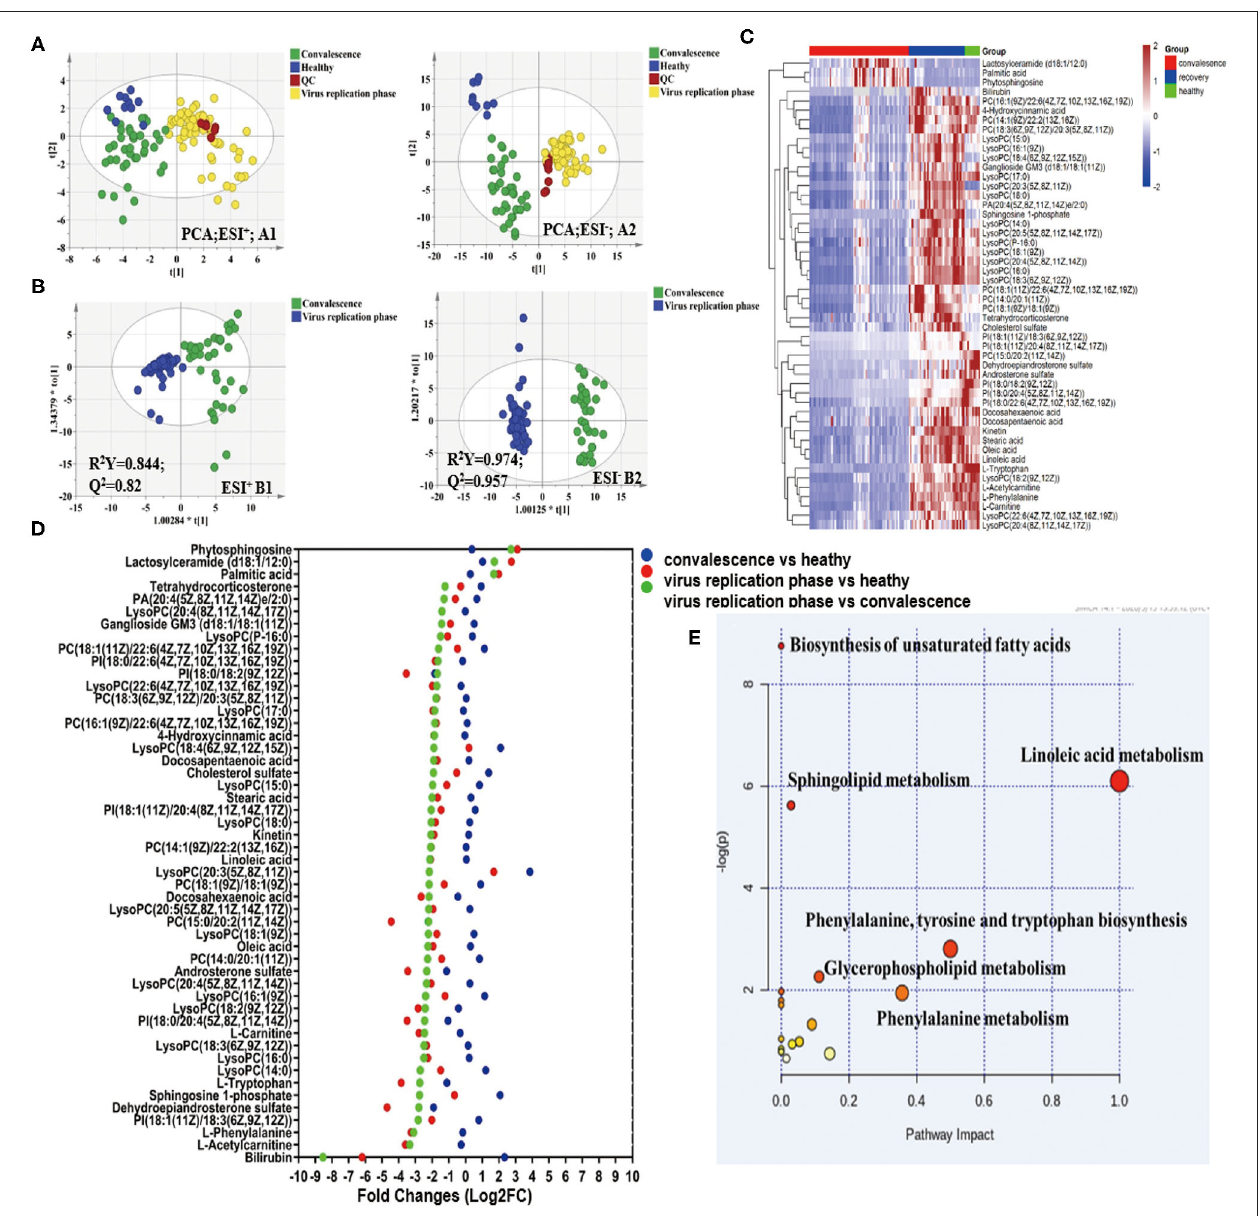
FIGURE 4 | Metabolomic profiling of COVID-19 patient plasma. (A) Principal components analysis of the metabolites across the three study groups based on the data of ESI + and ESI– modes. Colors display the subjects from different groups (blue, normal controls; yellow, virus replication group; green, convalescent group; and red, QC samples). (B) OPLS-DA plot of COVID-19 patients in virus replication phase and early convalescence. (C) Heatmap of 50 selected metabolites, the colors changing from red (upregulated metabolites) to blue (downregulated metabolites). (D) Cleveland plots. Fifty metabolites are ranked according to their fold changes in the virus replication group vs. convalescent group (the highest fold changes on the top; the lowest on the bottom). Fold changes in the virus replication group vs. normal controls and the convalescent group vs. normal controls are also shown. (E) MetPA. Pathway analysis was performed using MetaboAnalyst 4.0 for the 50 differential metabolites. The color and size of each circle are based on its p -value and pathway impact value,